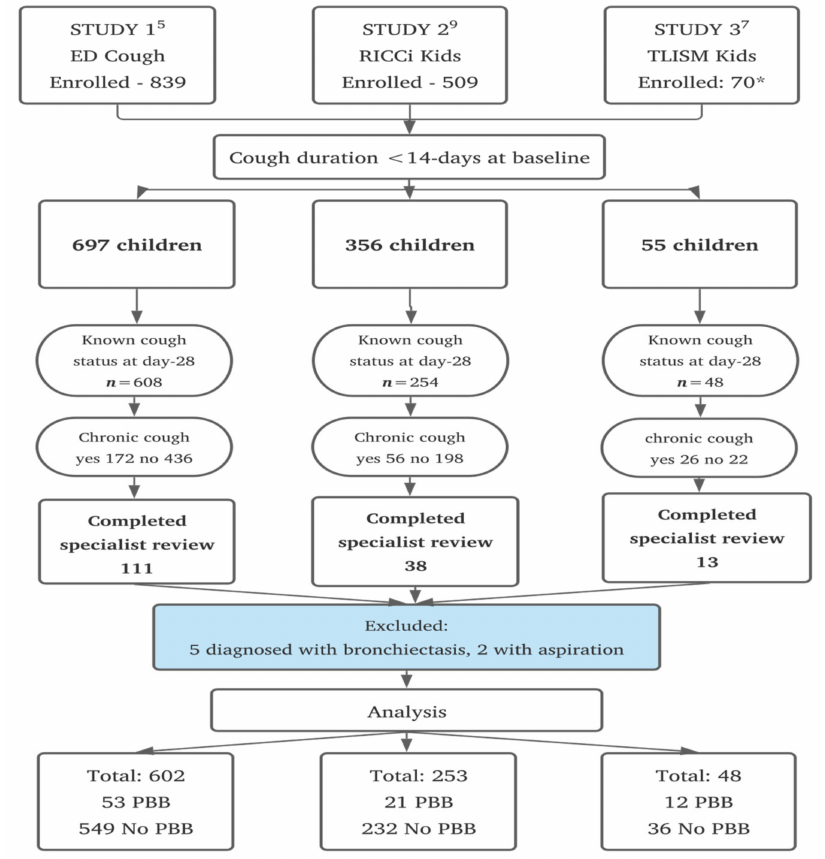
Figure 1. Stages to the final dataset for